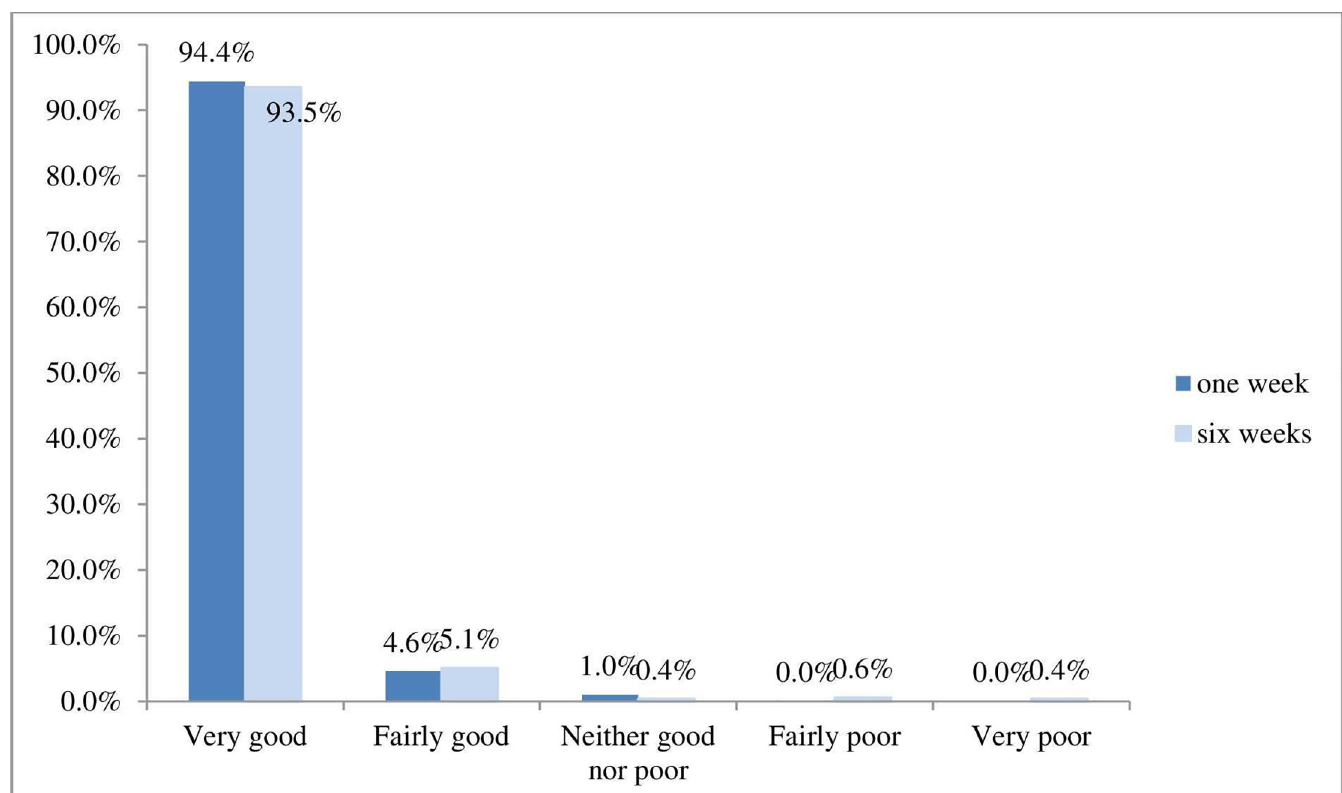
Fig 5. Patients’ experience of osteopathic care at one week and six